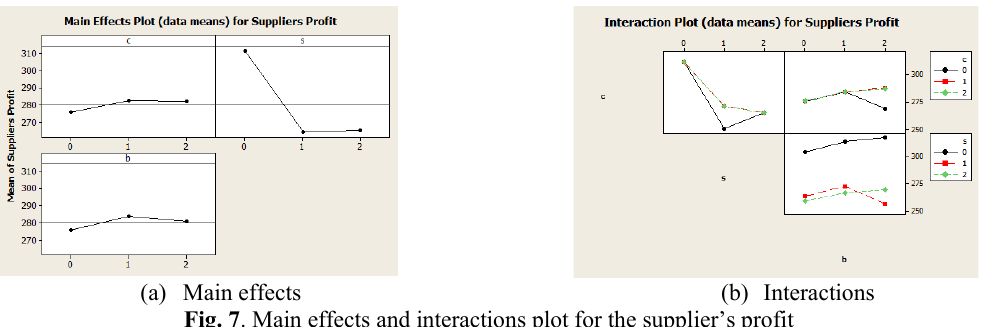
Fig. 7 . Main effects and interactions plot for the supplier’s profit